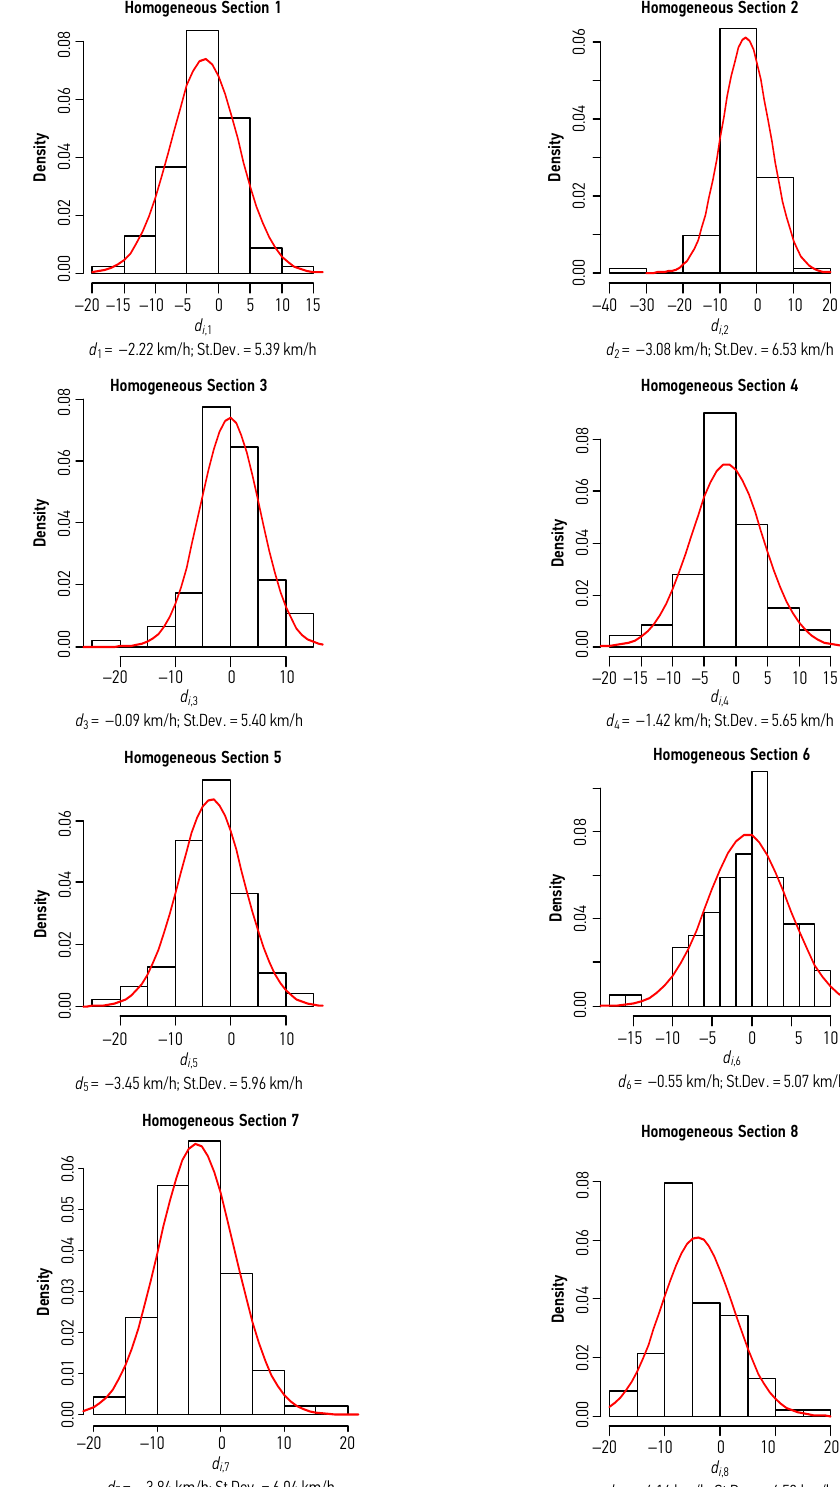
Fig. 8. Frequency density histogram of differences between simulated and real speed